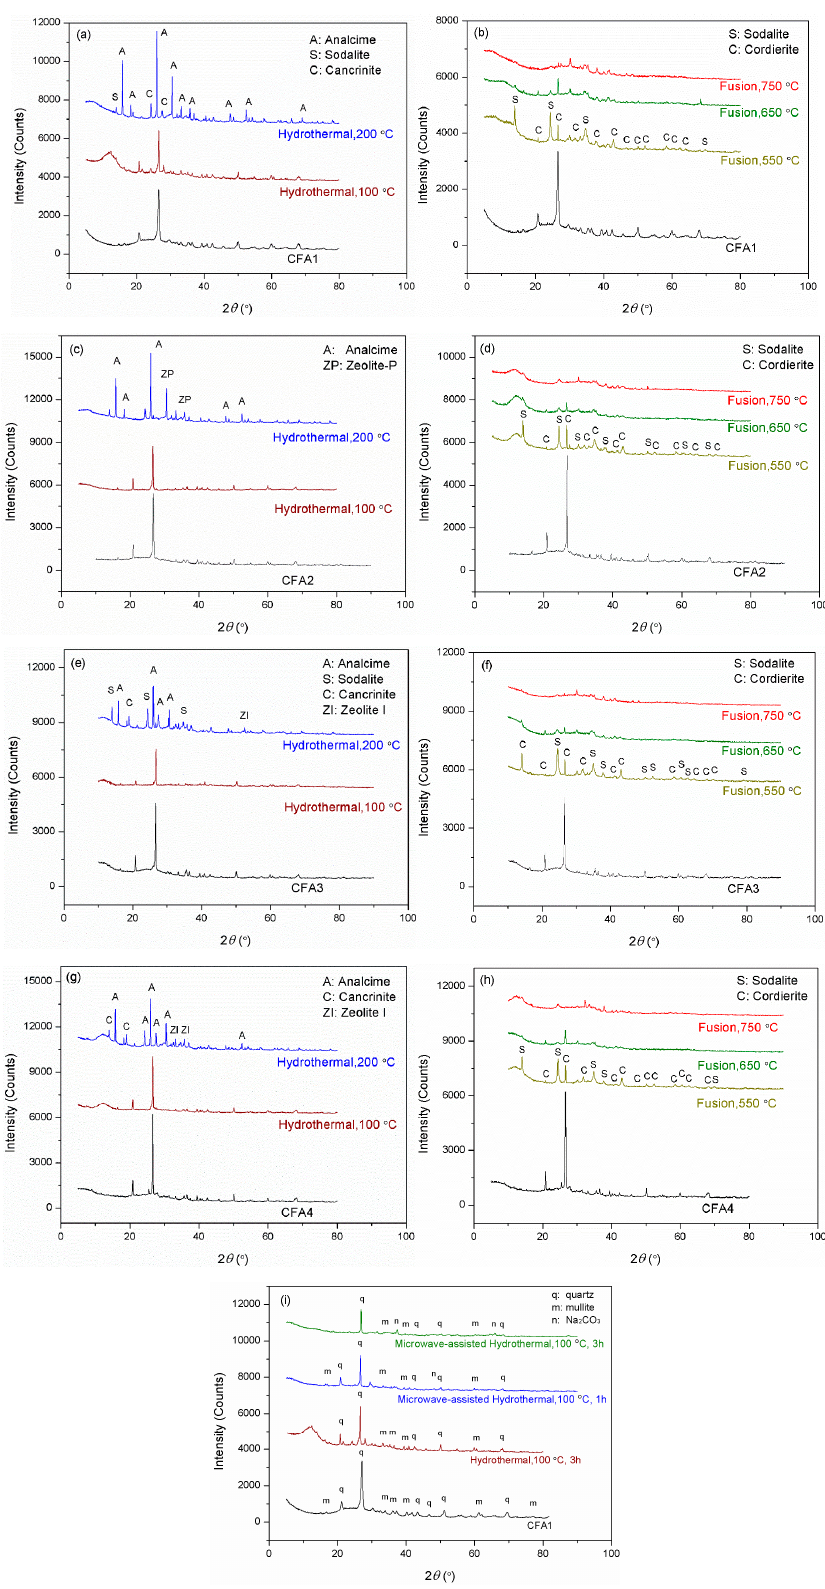
Figure 2. XRD patterns for the residues after hydrothermal treatments of ( a ) CFA1, ( c ) CFA2, ( e ) CFA3, and ( g ) CFA4, after microwave-assisted hydrothermal treatments of ( i ) CFA1, and after fusion treatments of ( b ) CFA1, ( d ) CFA2, ( f ) CFA3, and ( h ) CFA4.